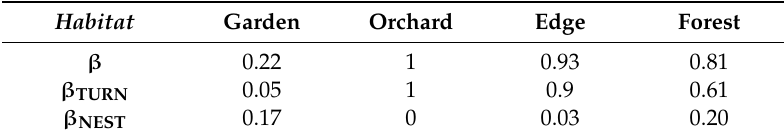
Table 2. Species composition dissimilarity and its decomposition by habitat between pitfall traps vs. nocturnal hand-collecting ( β : beta diversity = total dissimilarity between pitfall and NHC; β TURN : partition of the beta diversity linked to turnover; β NEST : partition of the beta diversity linked to nestedness).